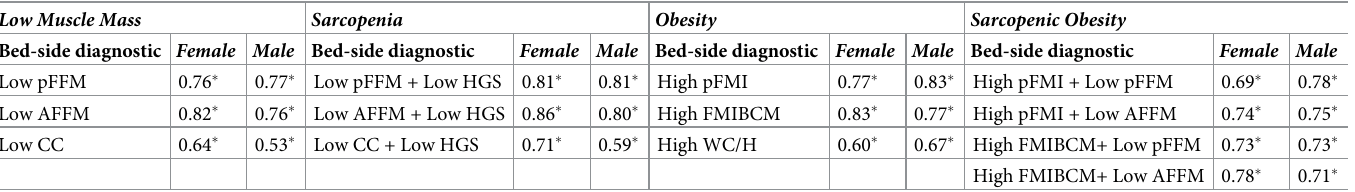
Table 6. Analysis of agreement between official and bed-side diagnostics of low muscle mass, sarcopenia, obesity and sarcopenic obesity. Low Muscle